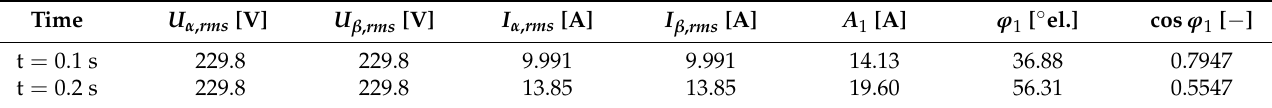
Table 14. Simulation results before and after the change (at steady states).